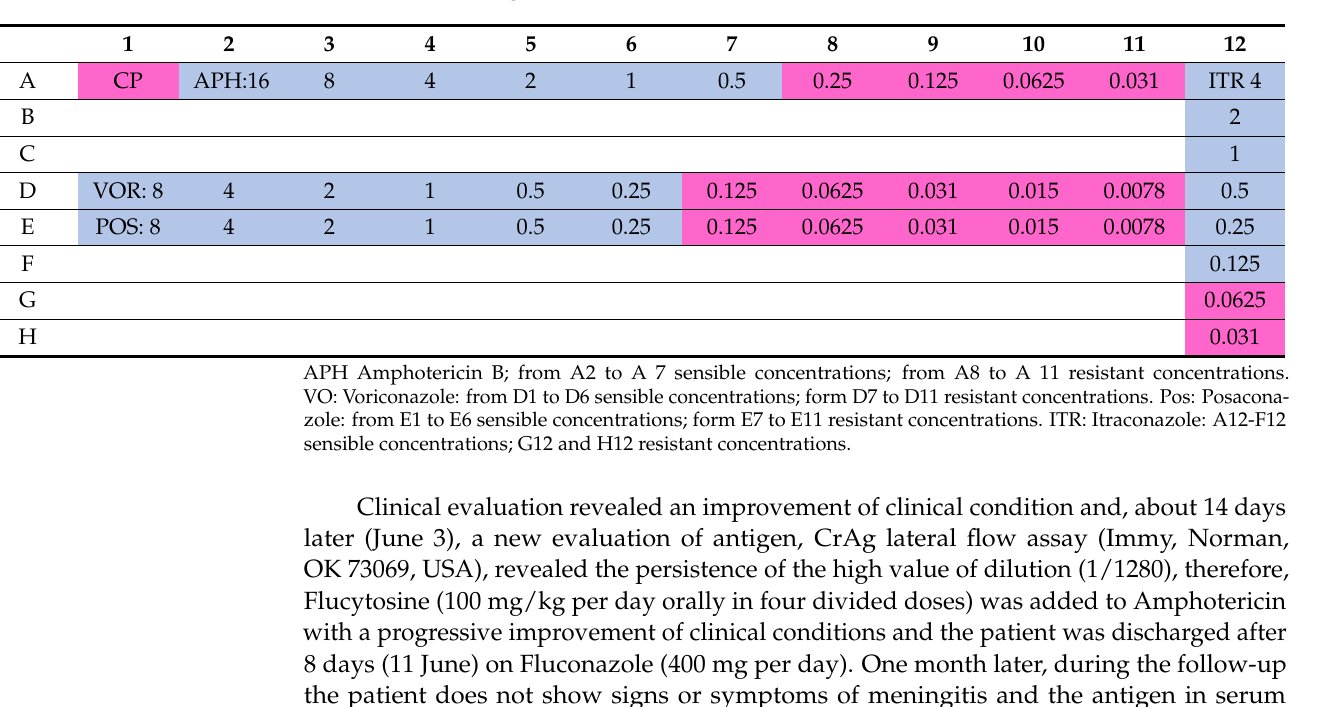
Table 2. Relative table of concentrations, expressed in Figure 3. A1 CP: Positive resistant control. Red color represents the resistant concentration (see Figure 3), while blue represents color the sensible concentration (see Figure